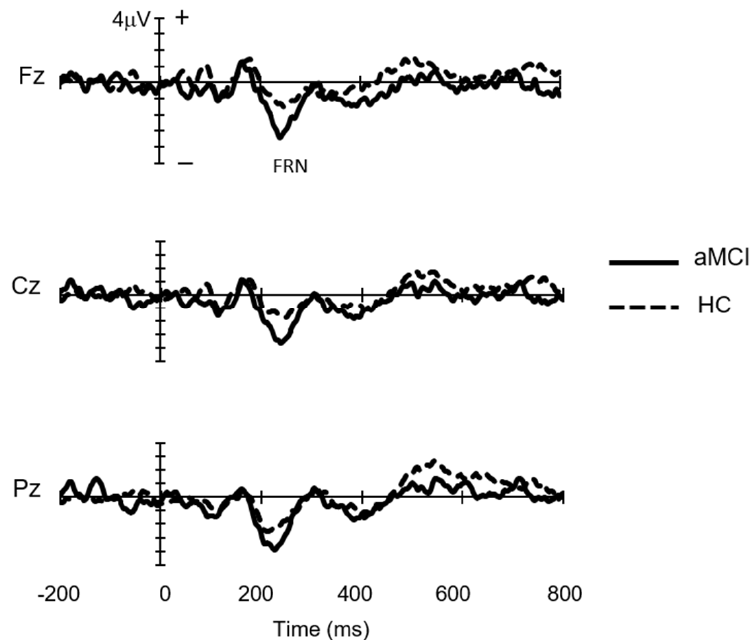
Figure 2. Grand-average waveforms at Fz, Cz, and Pz to positive feedback stimuli subtracted from negative feedback stimuli in mild cognitive impairment (MCI, n = 13) and healthy control (HC, n = 13) groups. FRN: feedback-related negativity.